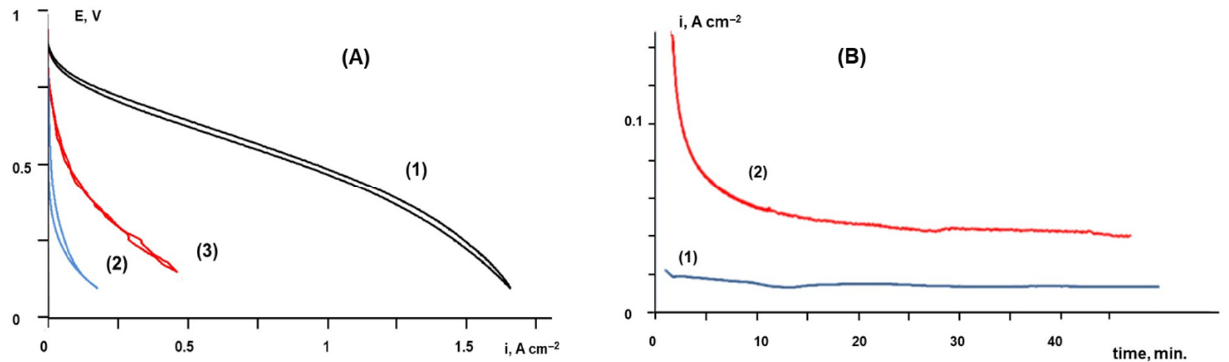
Figure 7. ( A ) Performance curves of a single cell at 65 ◦ C. Cathode: (1–3) Pt/C, air (600 mlpm). Anode: (1) Pt/C, pure hydrogen; (2) Pt/C, H 2 + 40 ppm CO; (3) PtMo/C, H 2 + 40 ppm CO. ( B ) Transients of current density measured after step change of the anode potential from ~0 V to 0.5 V vs. RHE. The working electrode, containing (1) Pt/C or (2) PtMo/C catalyst, was supplied with 400 mlpm flow of H 2 + 80 ppm CO. The counter electrode with Pt/C catalyst was supplied with pure H 2 at 50 mlpm flow.